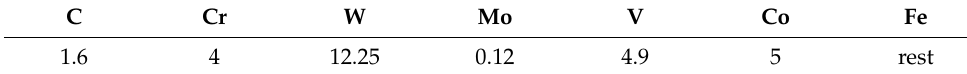
Table 1. Alloying elements and their proportion by weight in T15 grade steel.